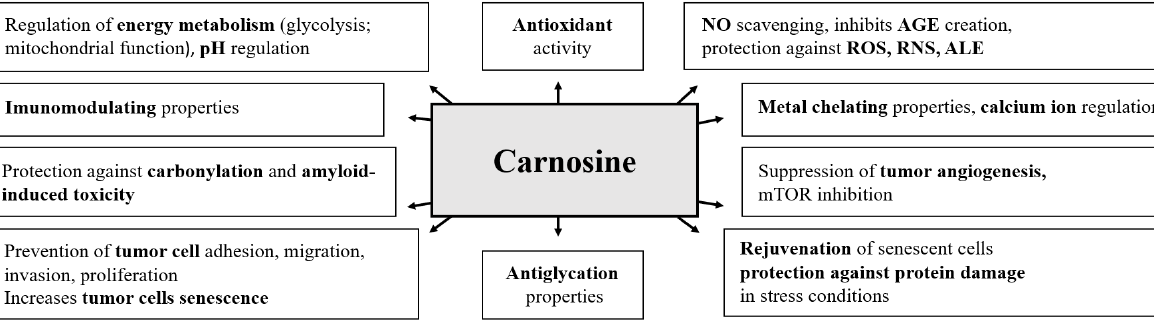
Figure 2. Biological activities of carnosine, simpli fi ed. ALE: advanced lipoxidation end products; AGE: advanced glycation end products; mTOR: mammalian target of rapamycin; NO: nitric oxide; RNS: reactive nitrogen species; ROS: reactive oxygen species. Additional information on carnosine’s molecular functions can be found in Supplementary Table S1. Beta-alanine is one of the most used sports supplements worldwide [23], as it im- proves muscle performance in active athletes, speci fi cally by increasing the concentration of carnosine in the muscles [24]. It is recommended for this purpose by the International Society of Sports Nutrition (ISSN) [25]. Besides carnosine and beta-alanine, N -acetylcar- nosine (NAC) and the synthetically prepared derivative chelate compound zinc-L-